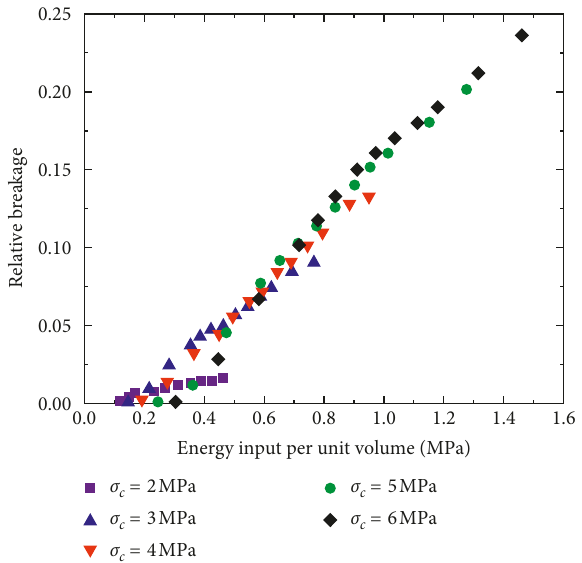
Figure 20: Correlation between B